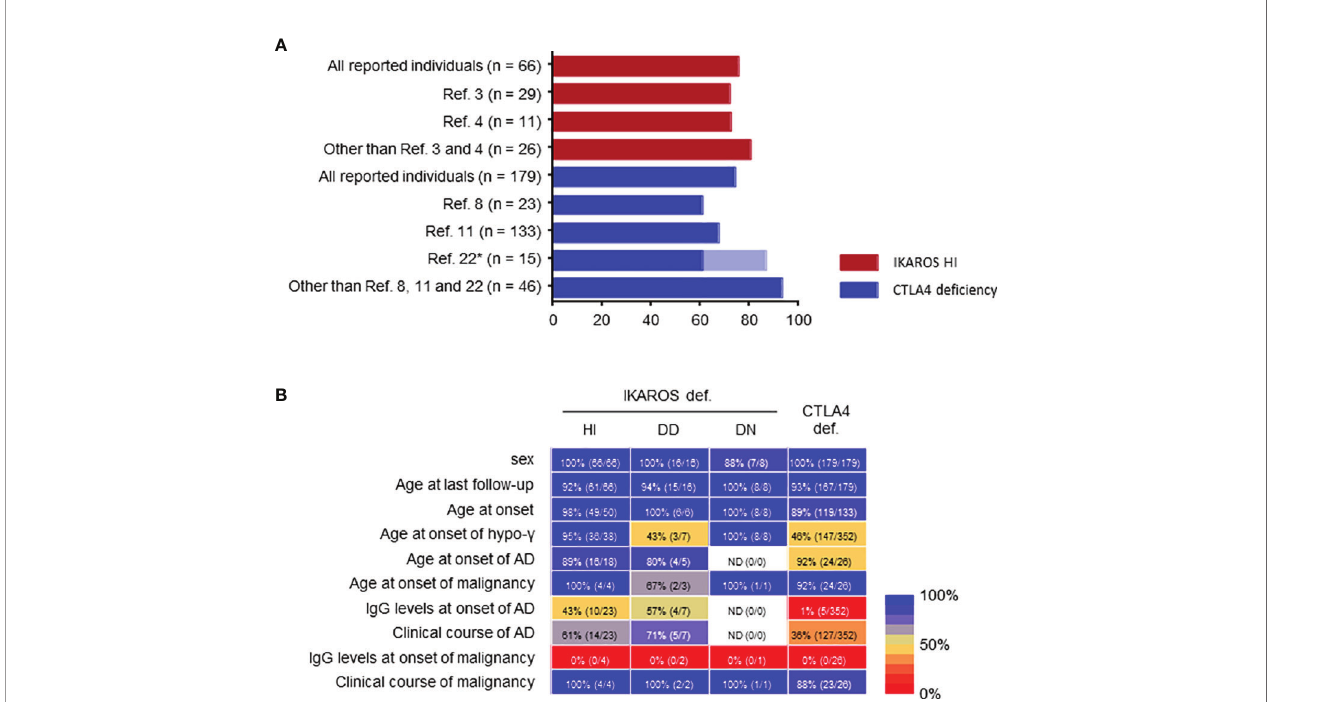
FIGURE 3 | Limitations of systemic literature reviews. (A) Penetrance in IKAROS HI and CTLA4 de fi ciencies. *Penetrance was described as 86.7% (13/15) in ref. 22, but re-evaluated as 60% (9/15) in ref.11 in the same patients. (B) Percentage of clinical data available presented as a heatmap: blue, higher percentage available; red, lower percentage available. If even a few data were described, it was considered as available. AD, autoimmune disease; hypo- g ,